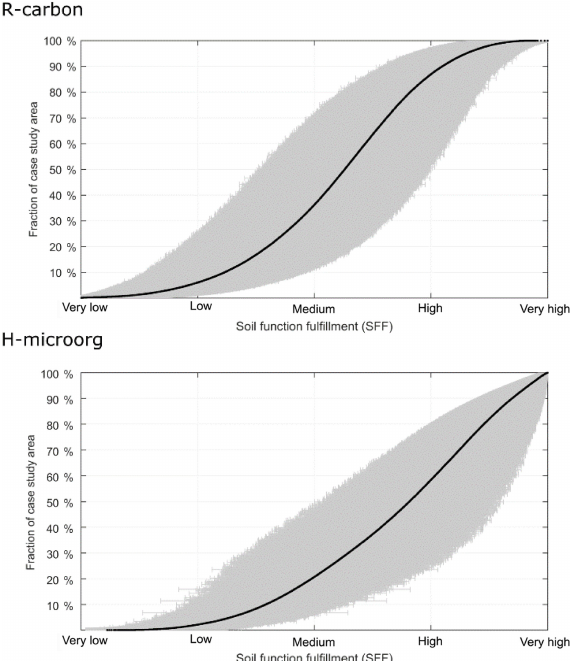
Figure 5. Cumulative distribution function (cdf) of SFF scores for type 1 (equation) for R-carbon and H-microorg for agricultural soils of the case study area and the uncertainty resulting from four ba- sic soil properties. SFF score: 1 (very low) to 5 (very high); black: mean SFF score per raster cell; grey: range ± MDM per raster cell, number of raster cells is about 450000; total area = 170km 2 .